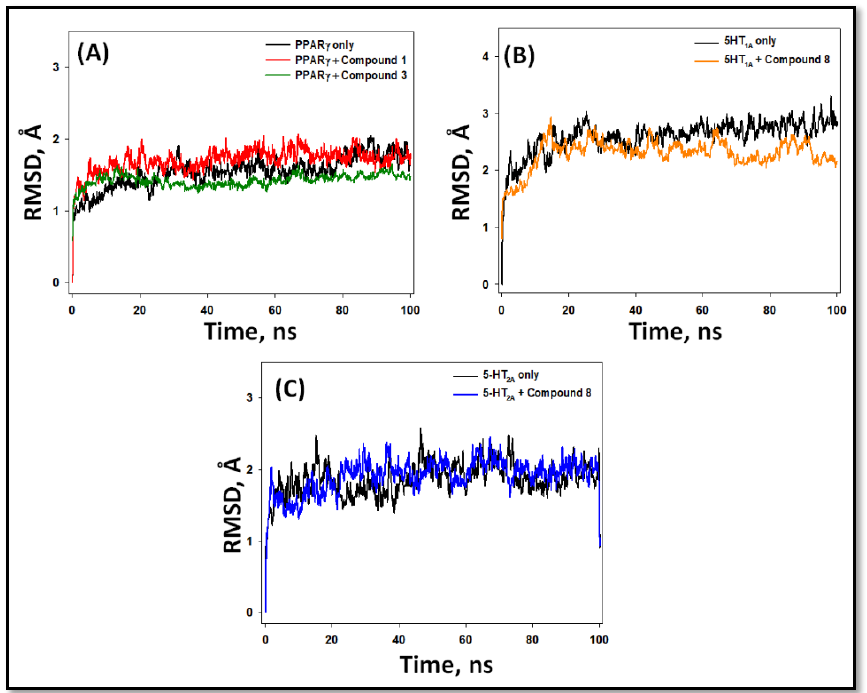
Figure 9. Root mean square deviation (RMSD) in the Cα -atoms of PPAR- γ, 5-HT 1A , and 5-HT 2A with their respective compounds. ( A ) PPAR- γ alone and in the presence of compounds 1 and 3 ; ( B ) 5-